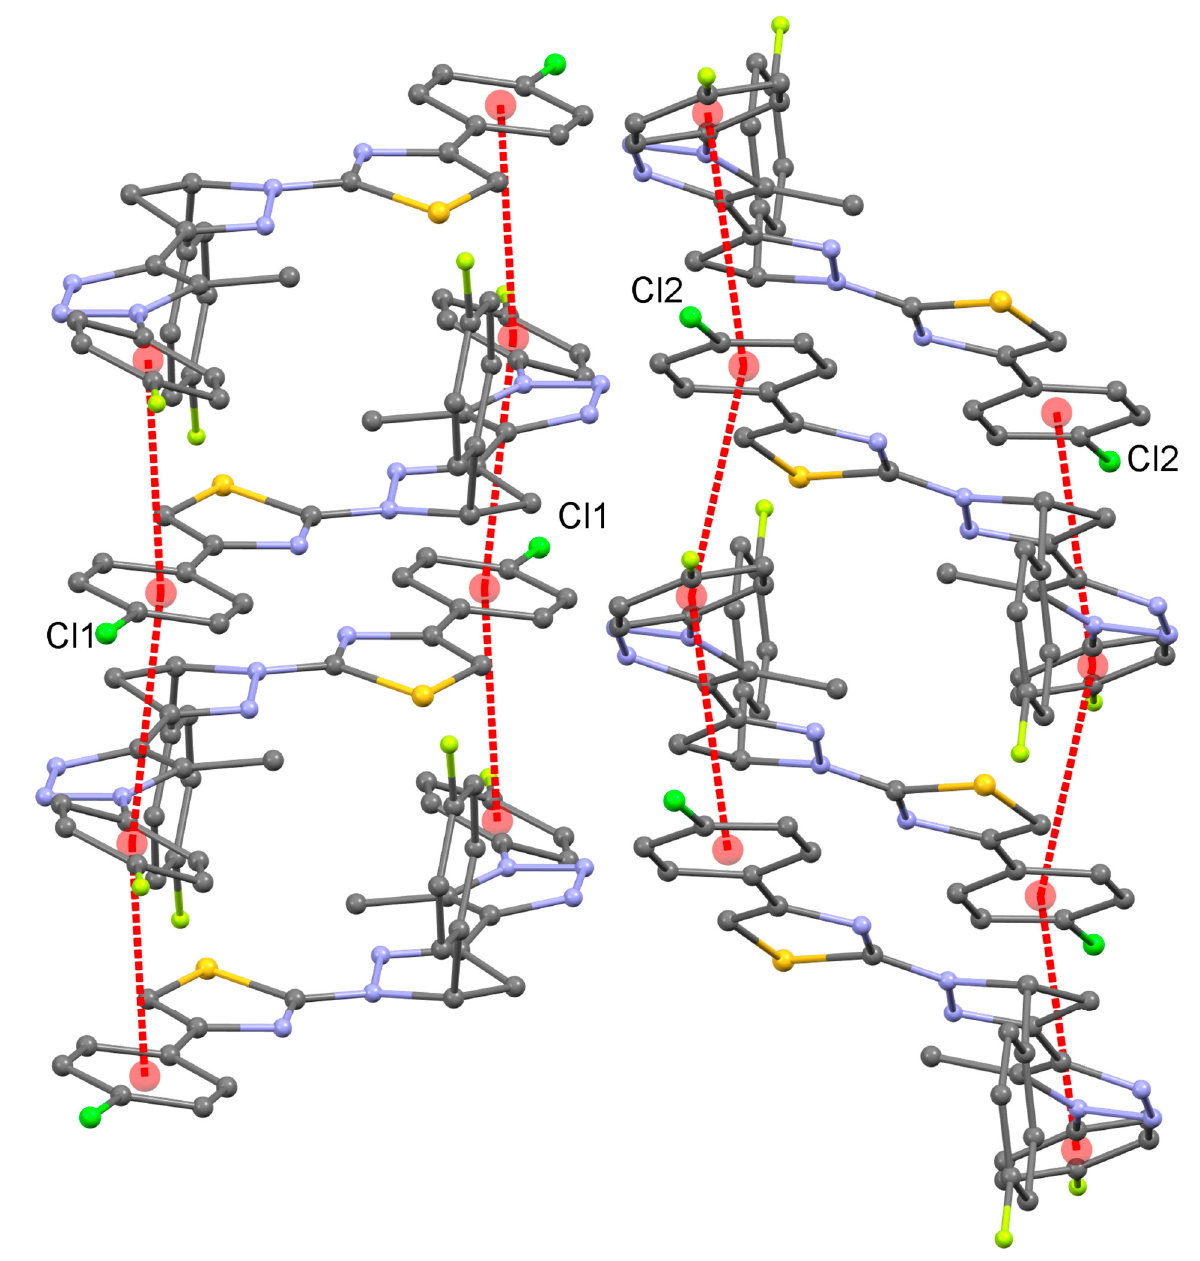
Figure 5. A segment of the crystal structure of 4 viewed approximately along the c -axis showing the stacking of molecules with ring centroid separation shown as red dashed lines. Table 2. Inter-ring twist angles (°) and centroid-to-centroid distances (Å). (The centroid-to-centroid distances shown are longer than is conventionally shown for π – π contacts but are used in this case for ease of comparison of the structures. (i) and (ii) refer to the first and second independent mole- cules.)